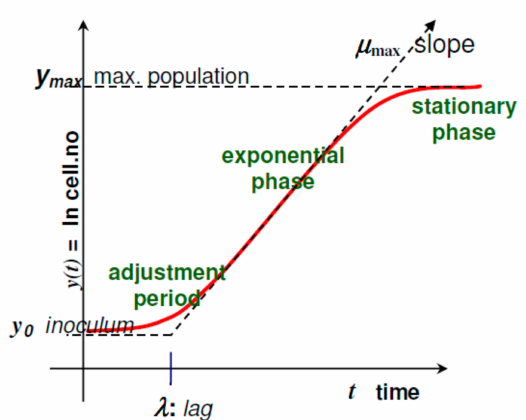
Figure 2. Microbial growth curve with description of the four parameters considered in the model proposed by [9]. (Reprinted from ref.